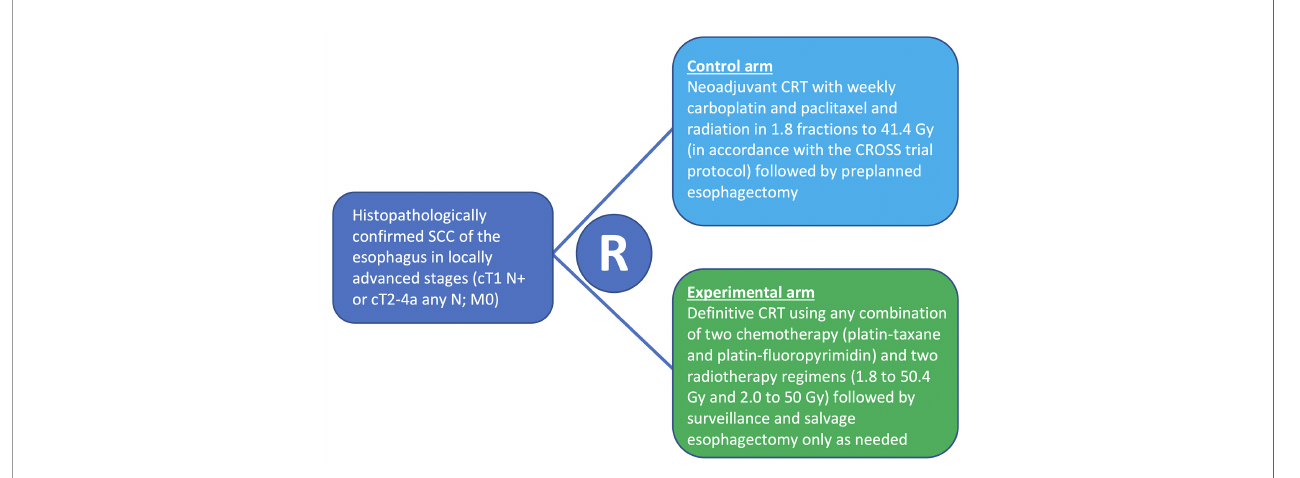
FIGURE 1 | NEEDS randomization